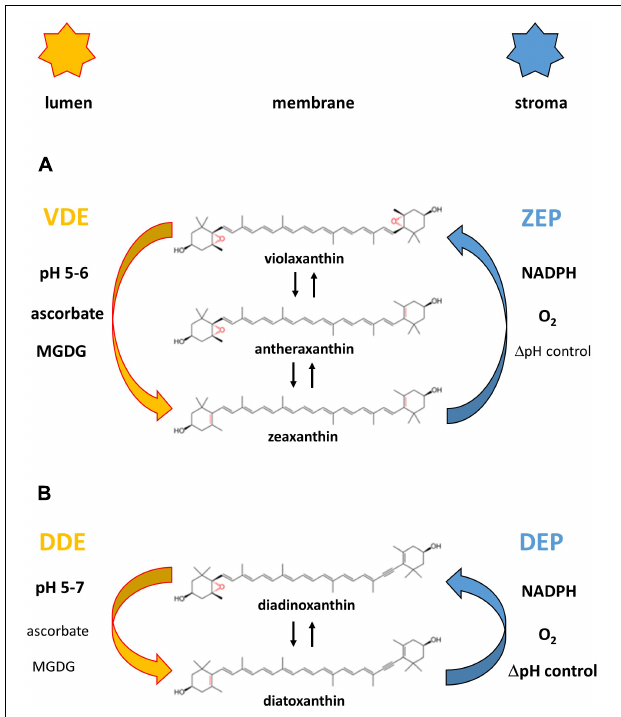
FIGURE 2 | Reaction sequences and enzymes of the violaxanthin (A) and diadinoxanthin (B) cycle. The violaxanthin cycle is present in higher plants and green and brown algae, the diadinoxanthin cycle is found in diatoms, haptophytes and dinophytes. Figure 2 also shows the cofactor requirements of the enzymes catalyzing the de-epoxidation reaction (violaxanthin de-epoxidase, VDE and diadinoxanthin de-epoxidase, DDE) and the epoxidation reaction (zeaxanthin epoxidase, ZEP and diatoxanthin epoxidase, DEP), respectively. Representation of the cofactors in bold or normal type indicates whether high or low concentrations of the respective cofactors are needed for high enzyme activity. The establishment of a proton gradient inhibits diatoxanthin epoxidation (high (cid:49) pH control) and is thus presented in bold type whereas zeaxanthin epoxidation is unaffected by the presence of the transmembrane (cid:49) pH ( (cid:49) pH control depicted in normal type). The pH value of the thylakoid lumen which leads to VDE and DDE activation (possibly by VDE or DDE dimerization) and membrane binding is also indicated for the two xanthophyll